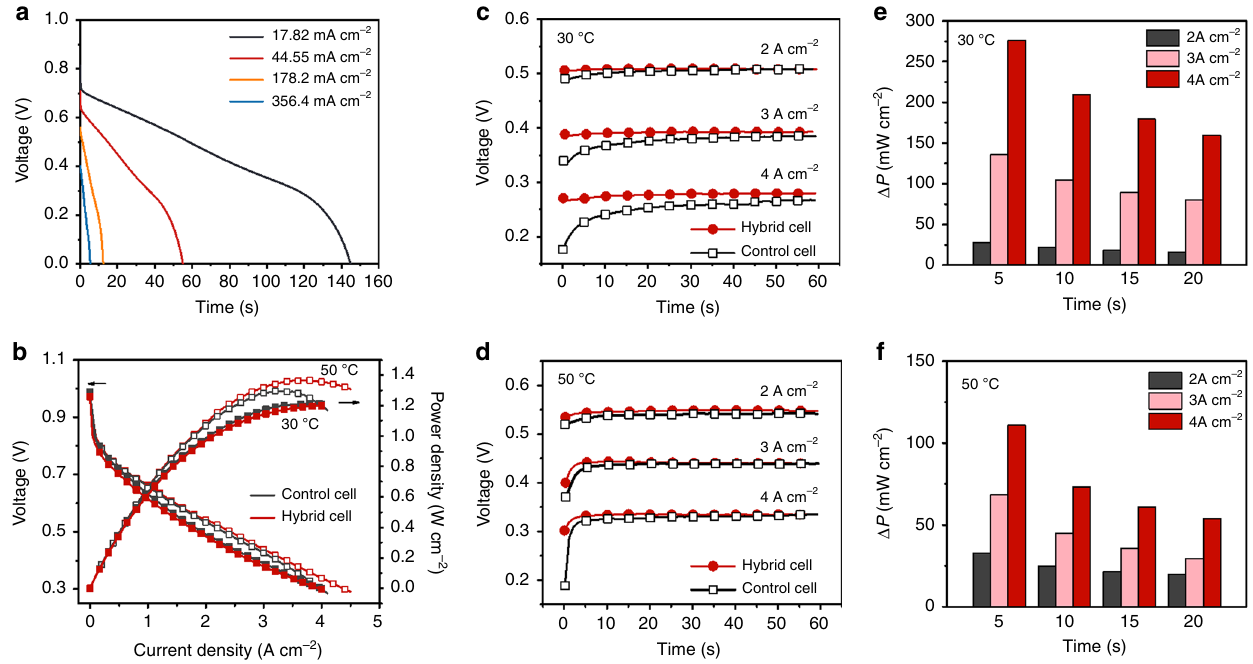
Fig. 3 Discharging pro fi les of the composite electrode and transient performance of cells. a Galvanostatic discharge curves of a WO 3 electrode discharged at different current densities measured in the air-capacitor con fi guration. b Polarization curves and power density of a hybrid cell (with WO 3 ) and a control cell (without WO 3 ) at 30 °C. Hundred percent humidi fi ed H 2 (stoichiometry = 1.5) and O 2 (stoichiometry = 4) were fed to the anodes and cathodes, respectively. c , d Voltages and e , f average P at a time scale of 5, 10, 15, and 20 s of the control cell and the hybrid cell upon switching the current output from 0.05 A cm − 2 to different current outputs at 30 and 50